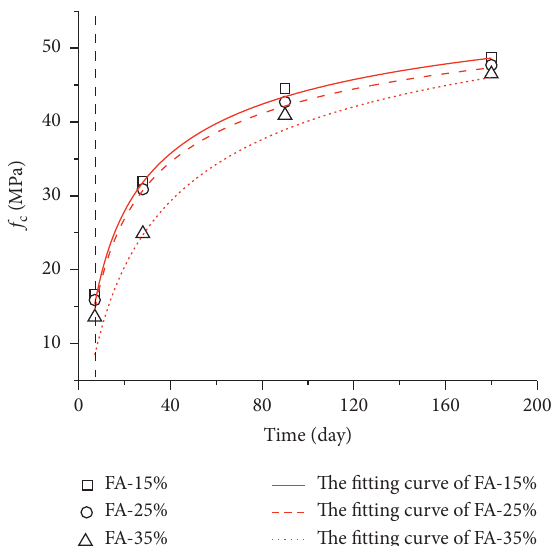
Figure 5: The compressive strength development at varying ages.